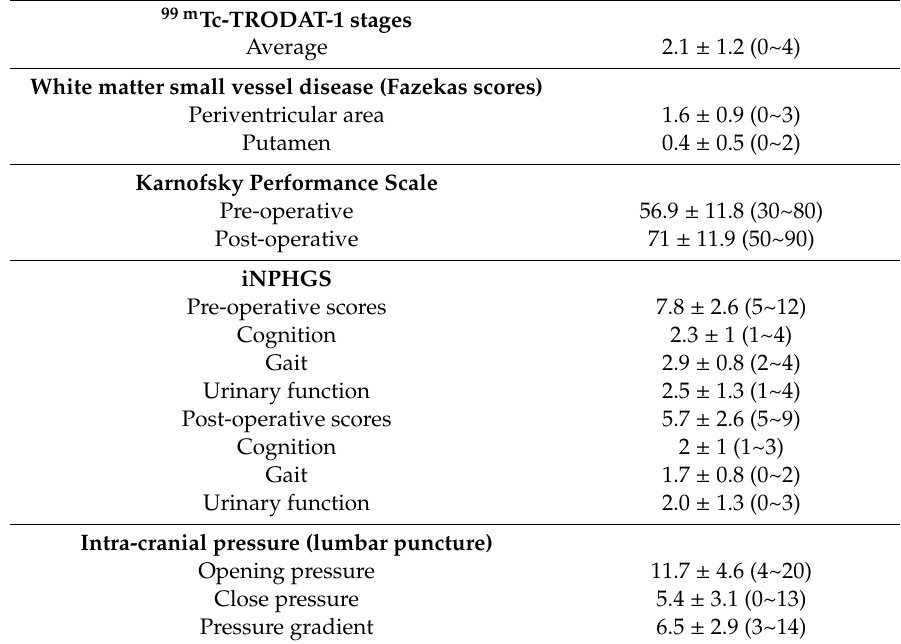
Table 2. Clinical staging of imagings, Karnofsky Performance Scale, iNPHGS and intra-cranial pressure gradient of normal pressure hydrocephalus patients ( n =